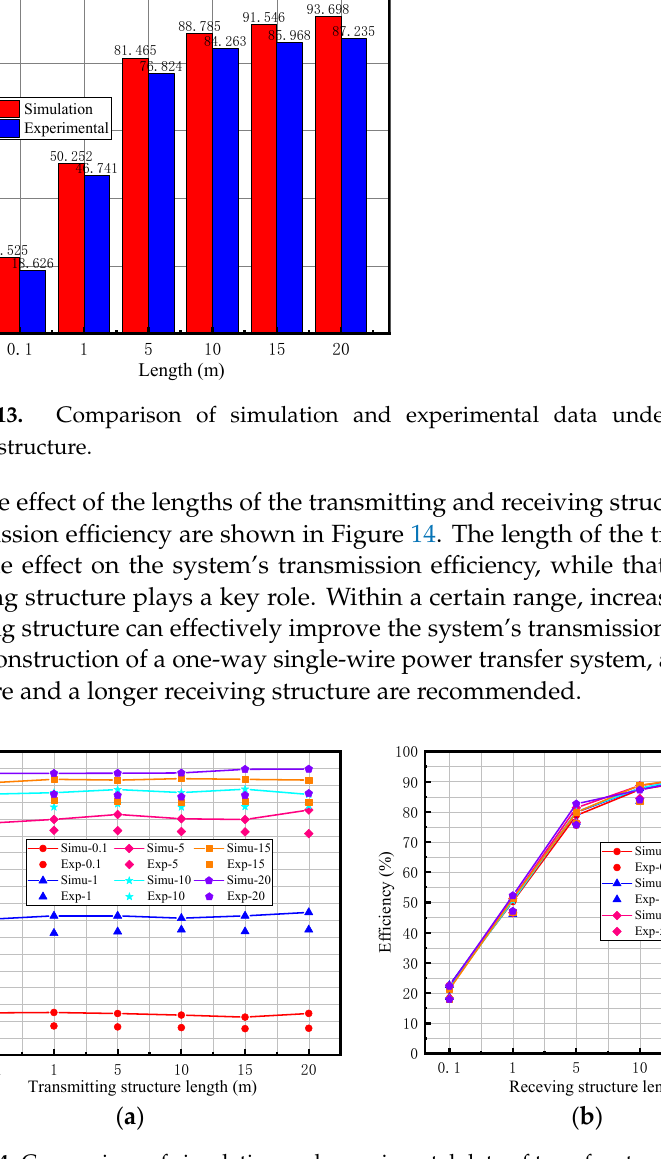
Figure 14. Comparison of simulation and experimental data of transfer structures under asymmetry: ( a ) length of transmitting structure; ( b ) length of receiving structure.